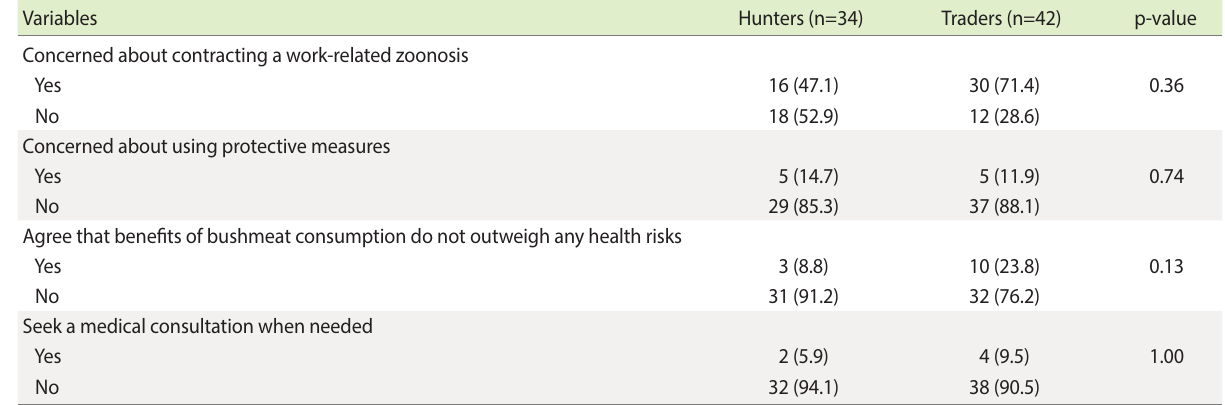
Table 3. Respondents’ attitudes towards zoonotic diseases